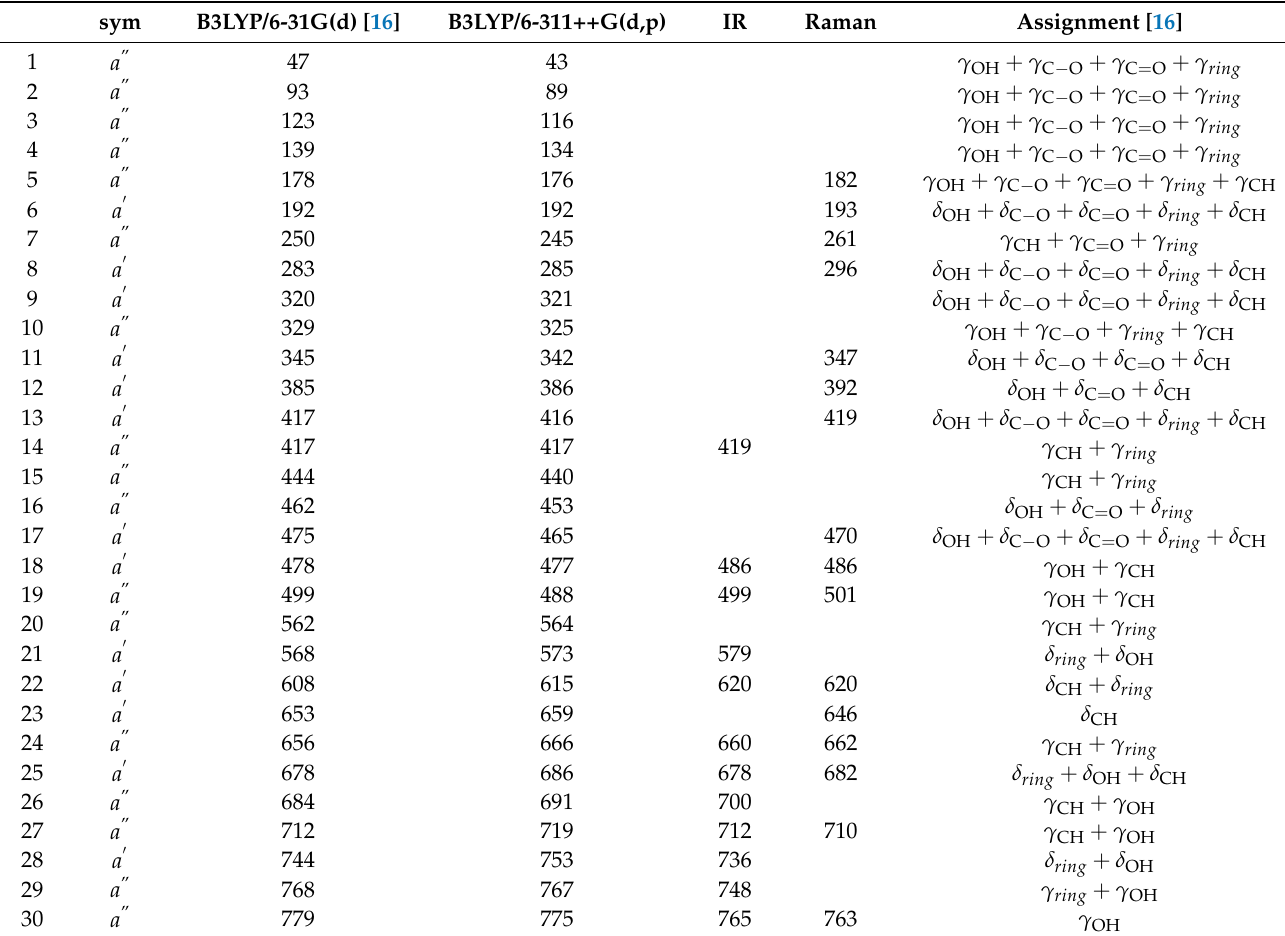
Table 1. Comparison of alizarin infrared and Raman vibrational frequencies computed at B3LYP/6-31G(d) [16] and B3LYP/6- 311++G(d,p) level of theory (present work). The experimental infrared and Raman frequencies (in cm − 1 ) and assignment were taken from Cyranski et al. [21] and Pagliai et al. [16], respectively. The normal modes were labeled as ν for stretching, δ for in plane bending or deformation, γ for out of plane bending or deformation, and sh for